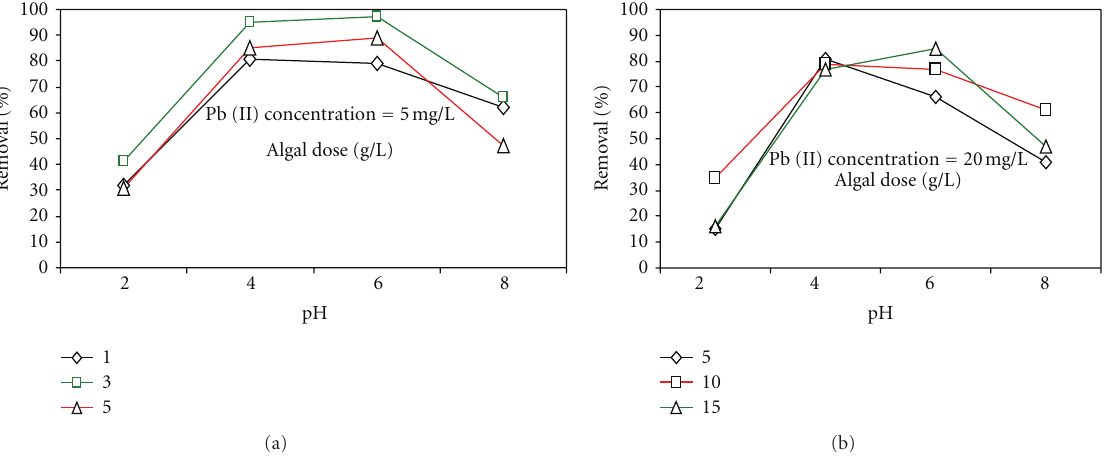
Figure 1: E ff ect of pH on sorption of Pb(II) by C. rivularis .